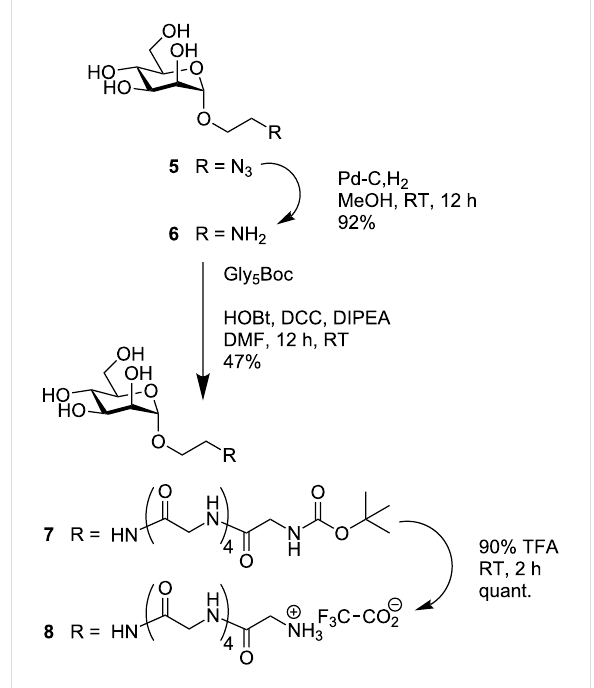
Scheme 1: Synthesis of the eastern part of target molecule 1